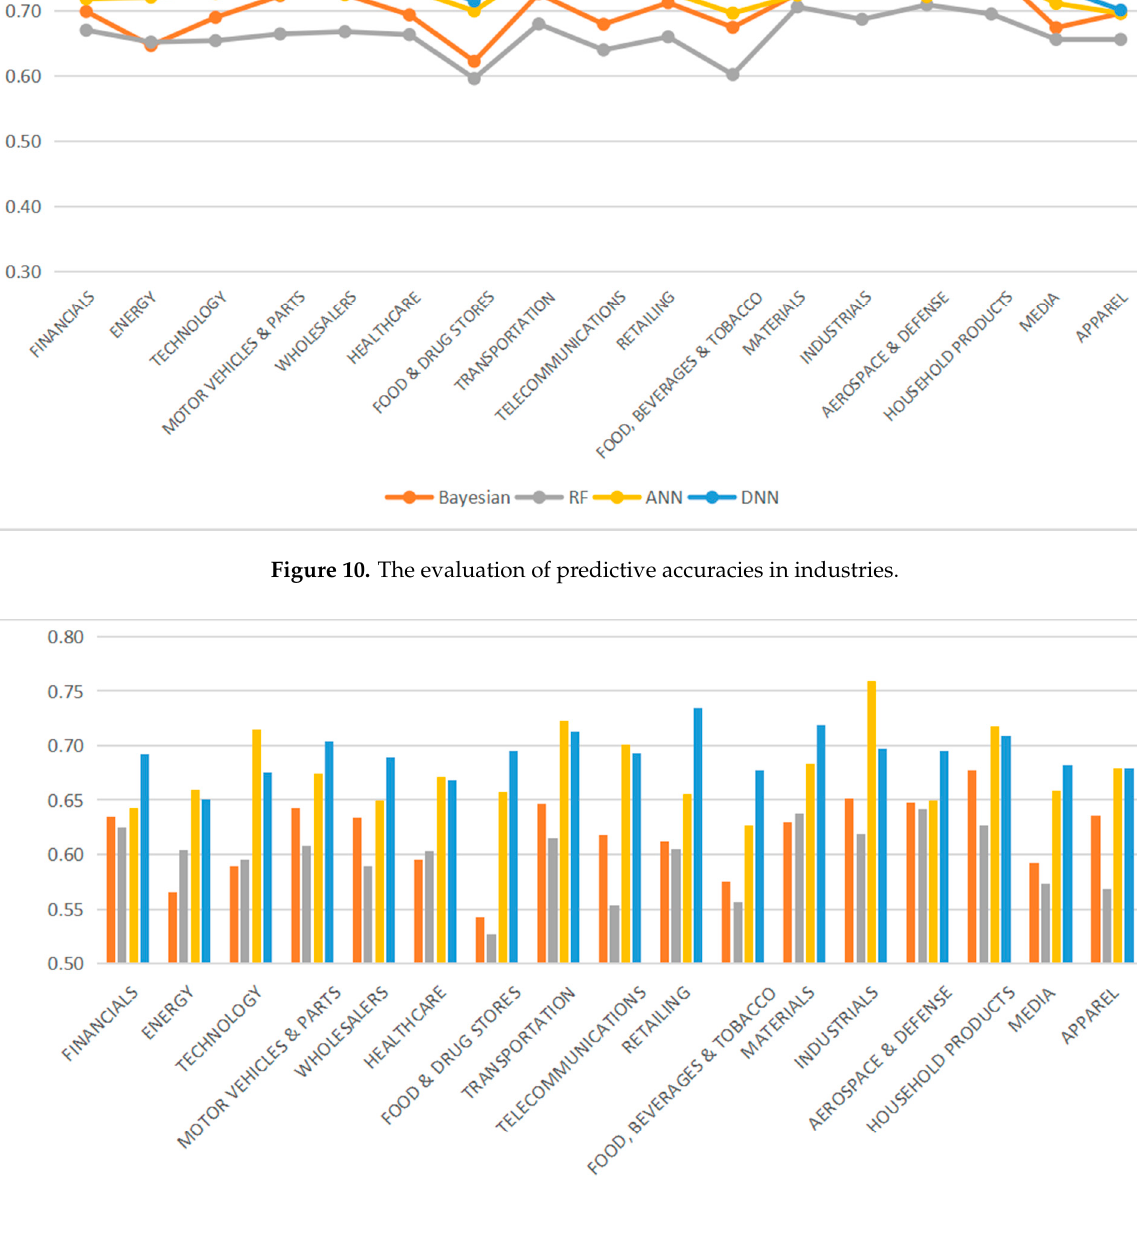
Figure 11. The evaluation of F1 score in industries.